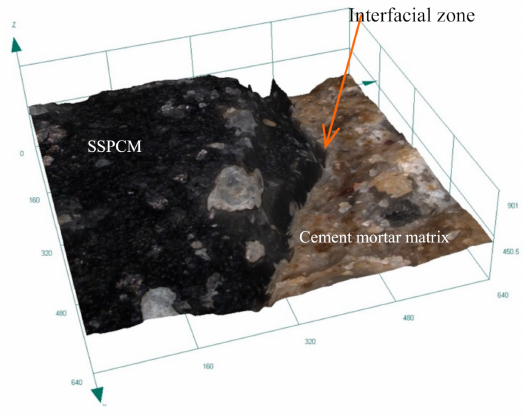
Figure 13. LSCM image of interfacial transition zone of